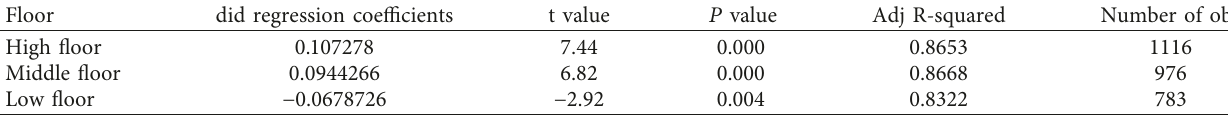
Table 5: Heterogeneity analysis results for residential buildings by floor.